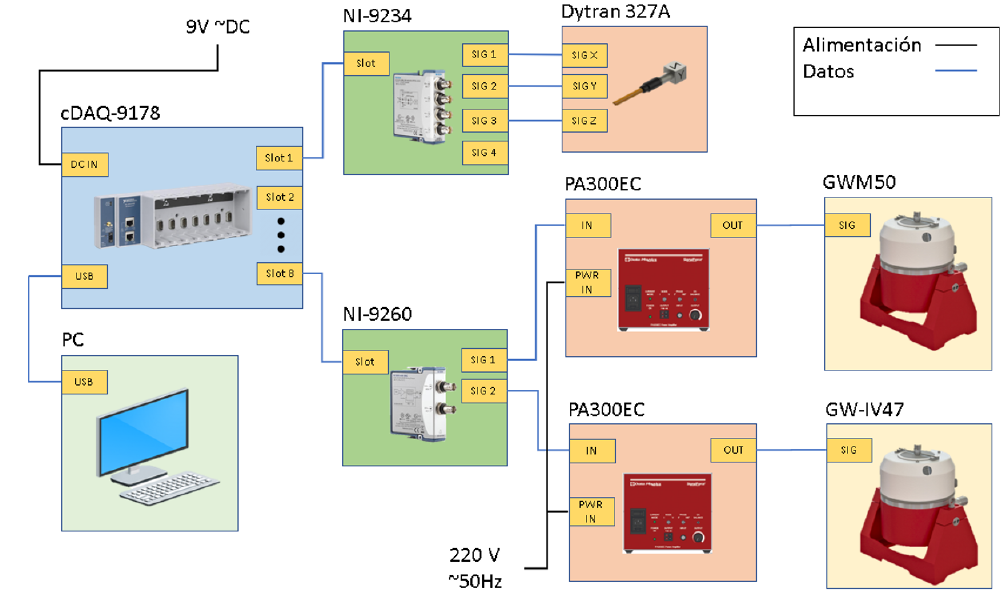
Figure 12. Electrical and electronic connection